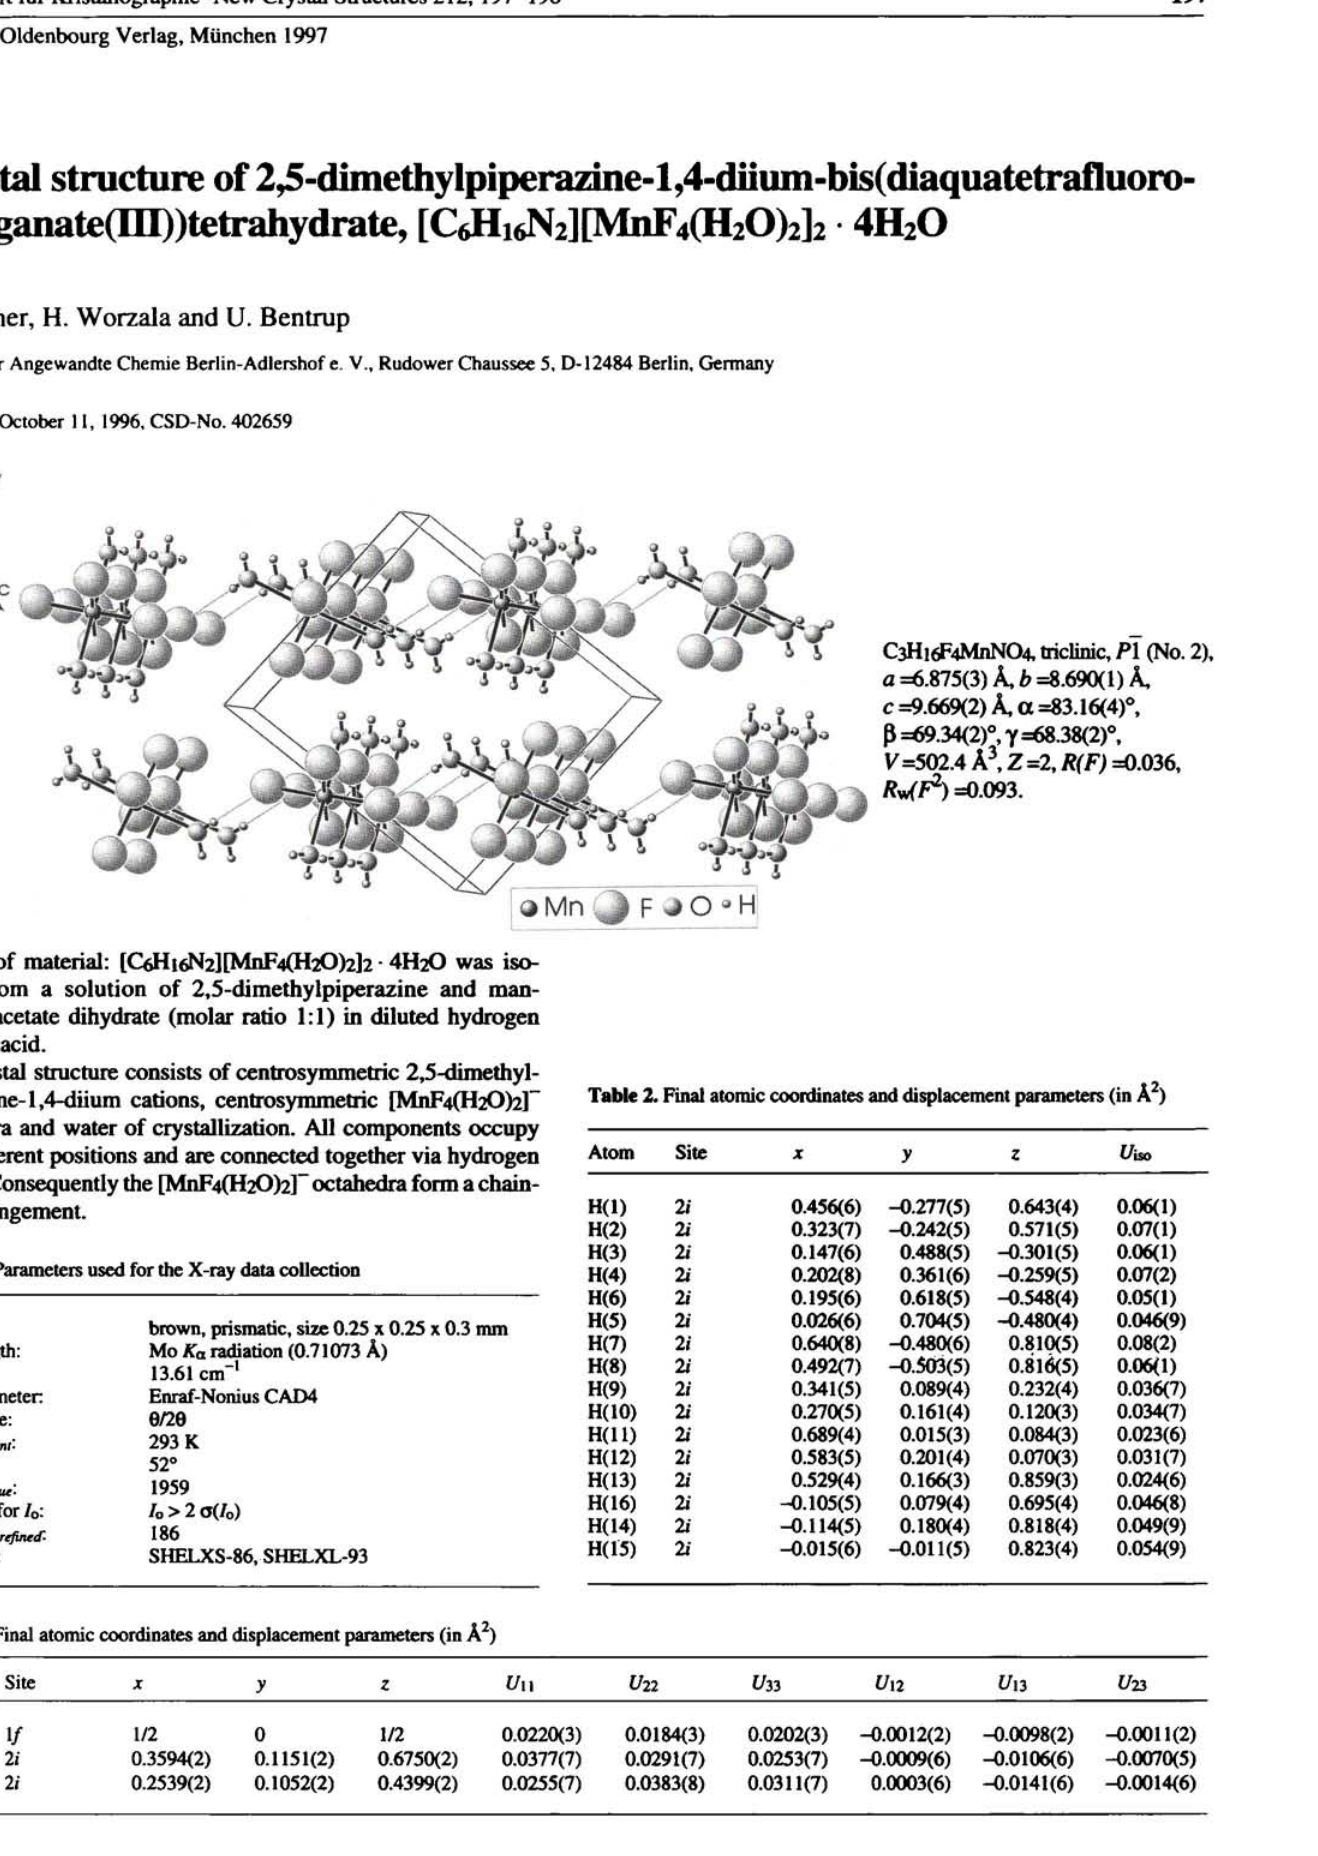
Table 3. Final atomic coordinates and displacement parameters (in Â 2 ) Atom